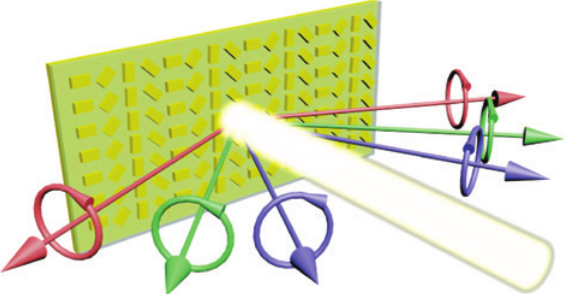
Figure 18: Illustration of a proposed circular dichroism spectrom- eter. The components with different polarizations are reflected in opposite directions, and each wavelength component is reflected at a different angle. Colors represent the different wavelength values. Adapted from Ref.